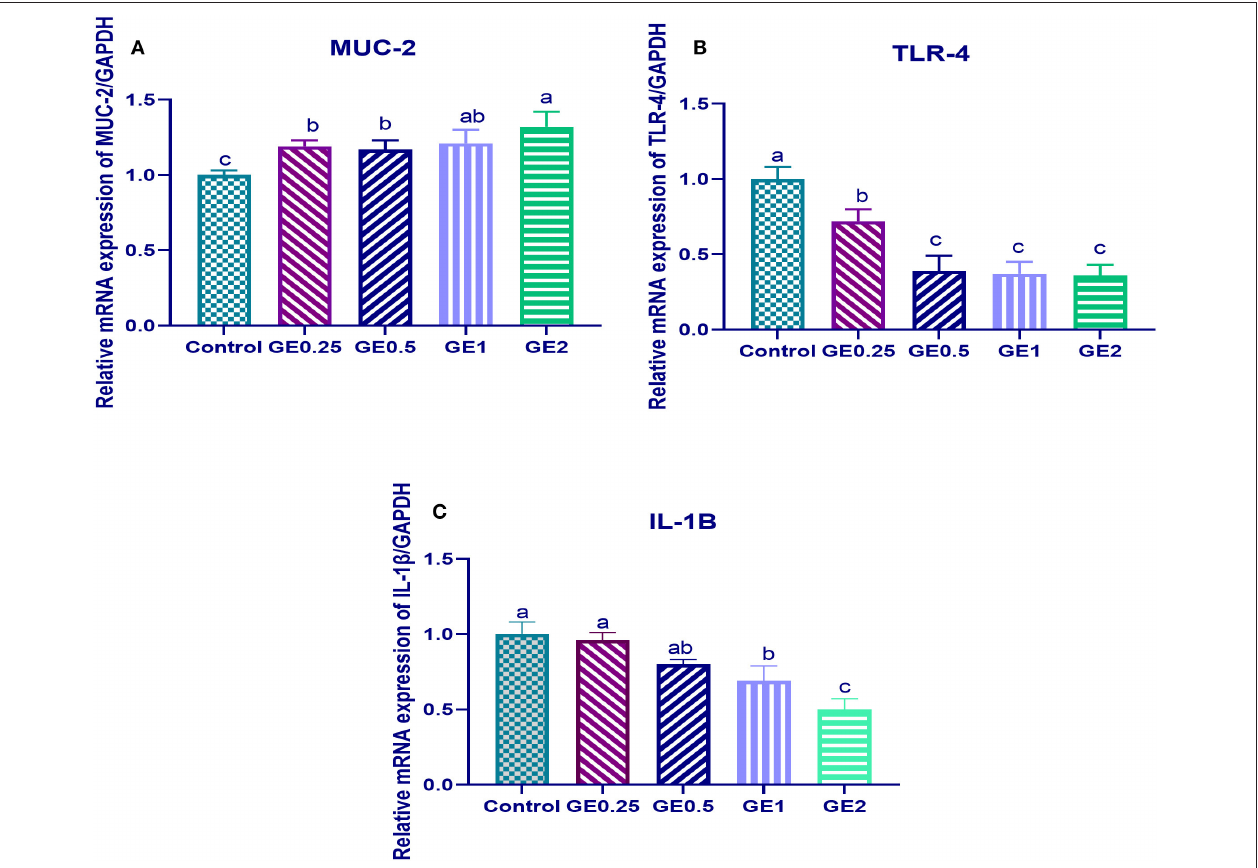
FIGURE 2 | Effects of dietary supplementation of Glycyrrhiza extract on Mucin (MUC-2) and Toll-like receptors (TLR-4) 7 days post-infection. Control referred to basal diet. GE0.25, GE0.5, GE1, and GE2 referred to basal diet supplemented with 0.25, 0.5, 1, and 2 g/kg Glycyrrhiza extract, respectively. Data represent mean values from 10 independent experiments, error bars indicate SE, n = 50 per group. (A) MUC-2 expression was significantly upregulated in all groups supplemented with GE compared with the control group ( P < 0.05). (B) TLR-4 expression was significantly downregulated in all groups supplemented with GE compared with the control group ( P < 0.05). (C) IL-1 β was significantly decreased in all groups supplemented with GE compared with the control group ( P < 0.05) in a dose-dependent manner.